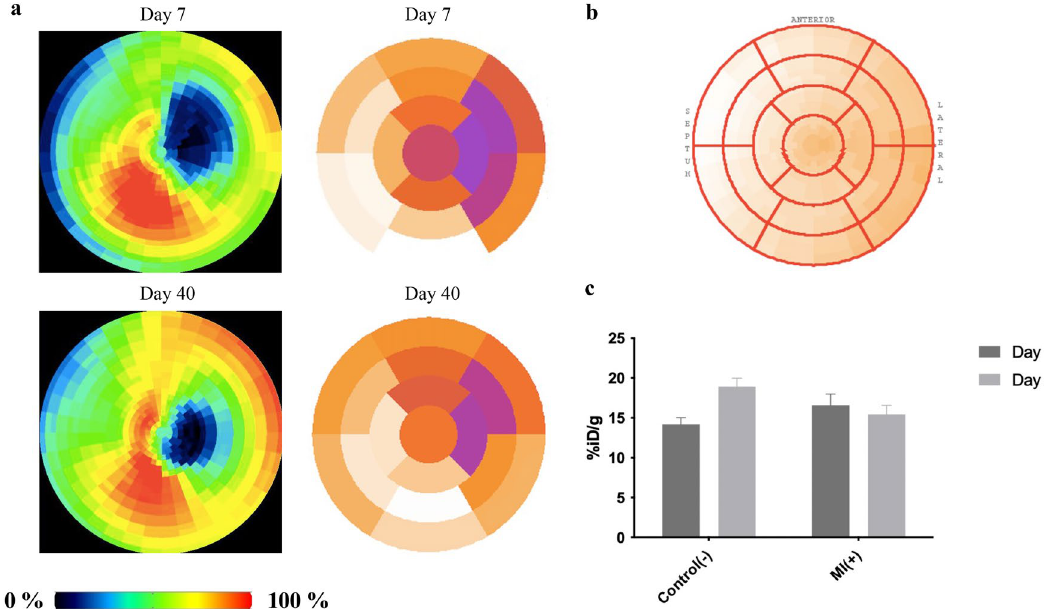
Figure 4. Metabolic heart activity (viability) measured through glucose uptake. ( a ) Conversion of PET images to maps of radiotracer activity in the heart (left) and their counterparts presented as polar maps for MI( +) mice (right). A reduction in the metabolically inactive zone can be seen in the walls and apex segments. ( b ) Scheme of the polar map by 17 AHA segmentation with indication of septum, anterior and lateral directions. ( c ) Graph for dual cardiac viability PET imaging in control(−) and MI(